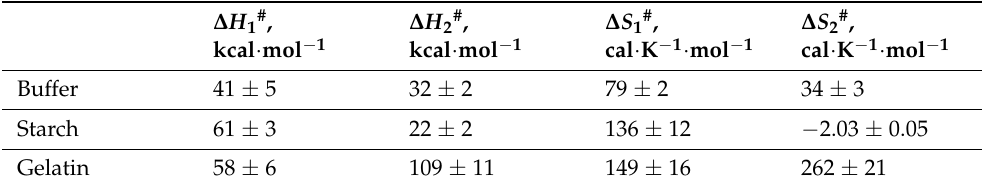
Table 1. Activation parameters for thermal inactivation of butyrylcholinesterase.